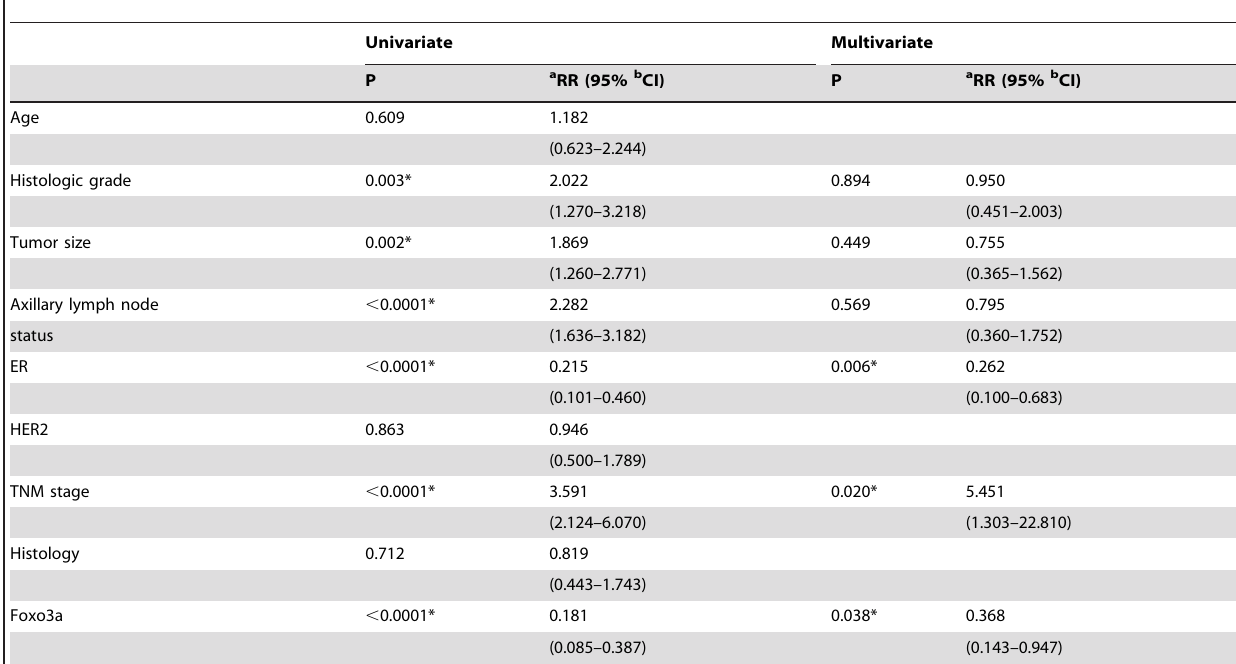
Table 2. Prognostic factors in 70 breast cancer patients compared with overall